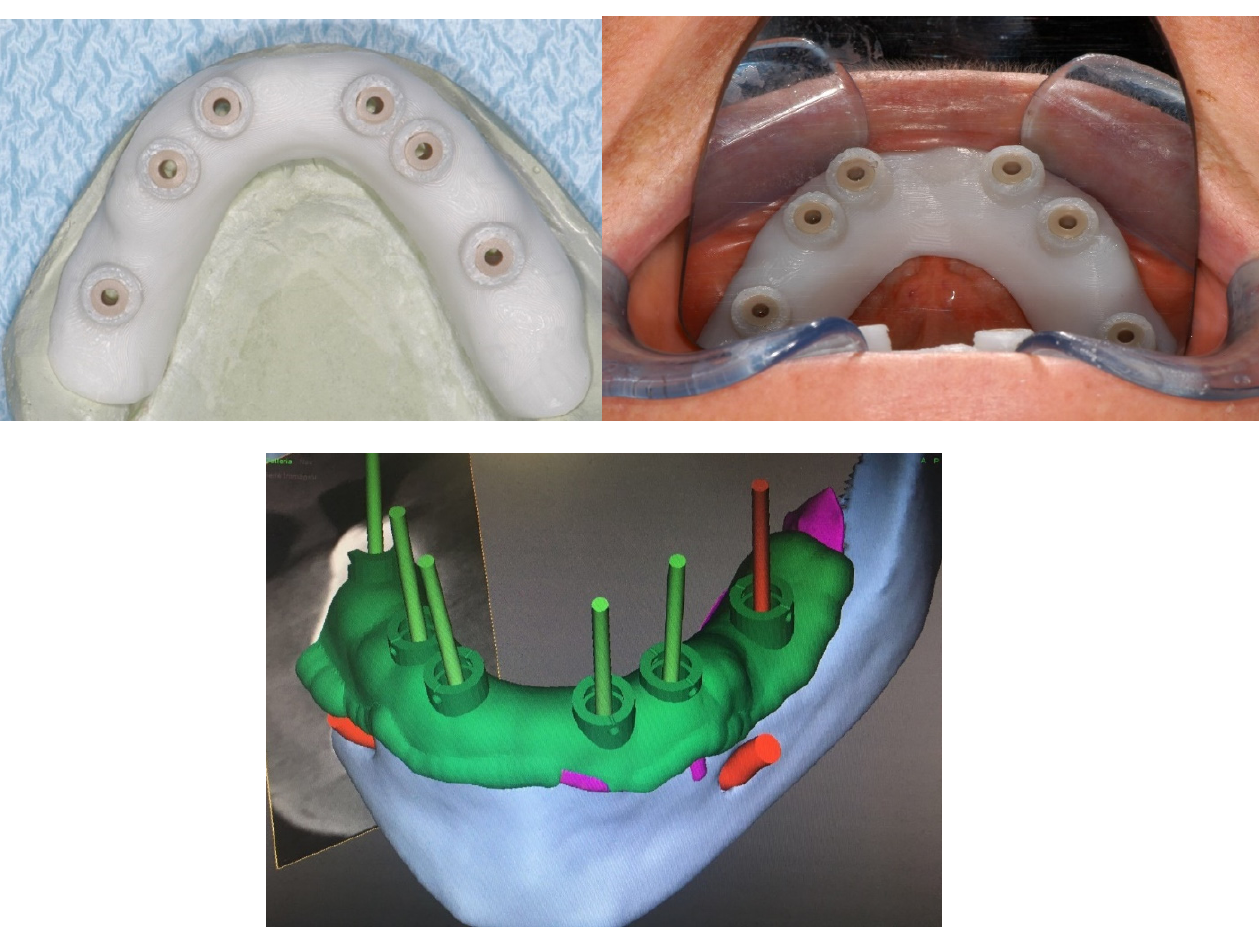
Figure 1. Positional guide for the implant placement.